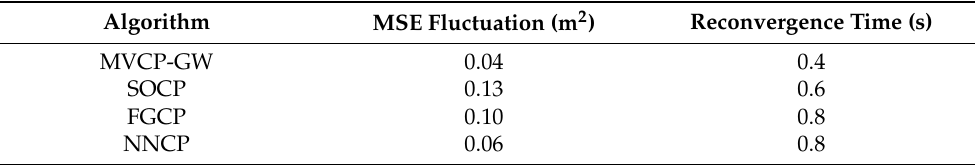
Table 2. Comparison of algorithm performance in mutation scene (20% of the vehicles lost satellite signals).